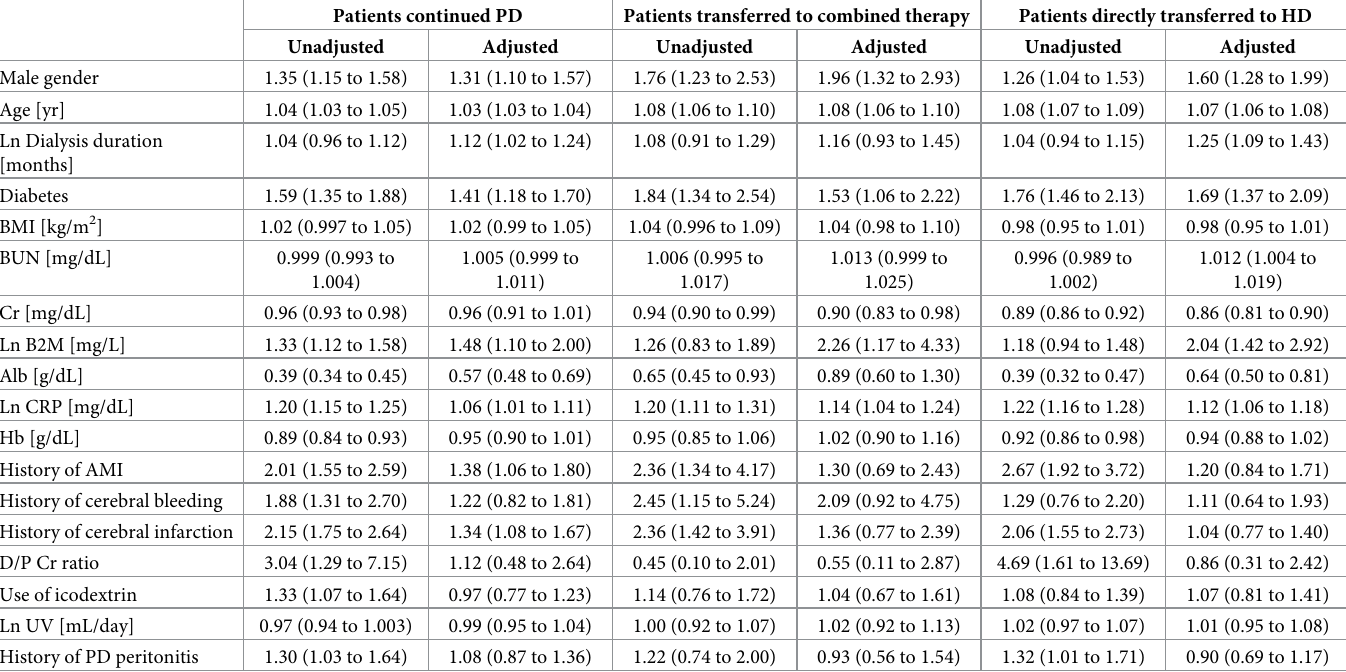
Table 4. HR and 95% CI of all-cause for each dialysis